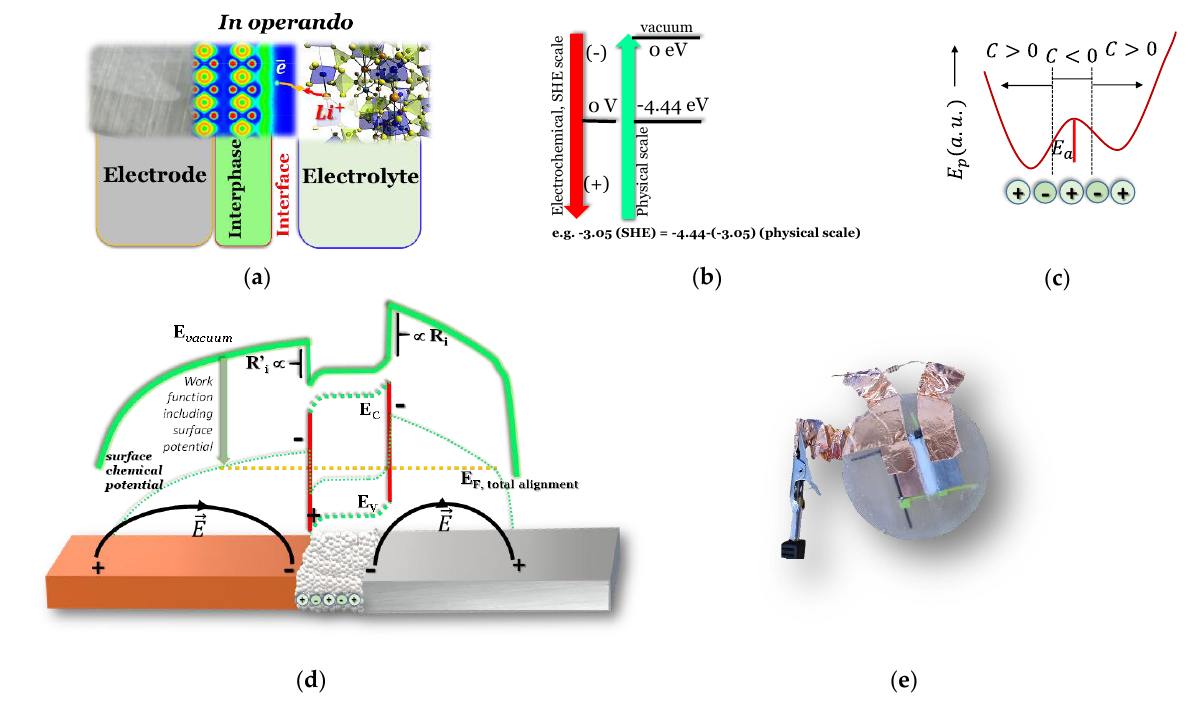
Figure 2. ( a ) Schematic interplay of the constituents of a battery cell in operando ; ( b ) absolute chemical potentials having as reference the standard hydrogen electrode (SHE) and the vacuum at 0 eV in the physical scale that relates more directly with the work functions of the materials; ( c ) potential energy E p showing positive polarization at both interfaces of a cell containing a dielectric. The maximum corresponding to the activation energy, E a , is a metastable configuration where both ends have equal polarization signs; ( d ) extended electrode highly resistive cells, where the contact is made difficult by quantum wells/barriers, and each electrode aligns the surface chemical potentials with the dielectric, independently; but, along the cell, there is at least one point for which all the chemical potentials equalize. The latter energy may correspond to the Fermi level or electrochemical potential. The internal contact happens through the electric field, made possible by SPP; ( e ) photo of a Zn/SiO 2 /Cu cell used to perform the SKP analysis when connected to a resistor. Note: the Al/insulator/Cu used had Al and Cu tapes connected to the resistor and SKP instrument to avoid additional heterojunctions. Table 1. Physical properties of the studied dielectrics and solid electrolytes.